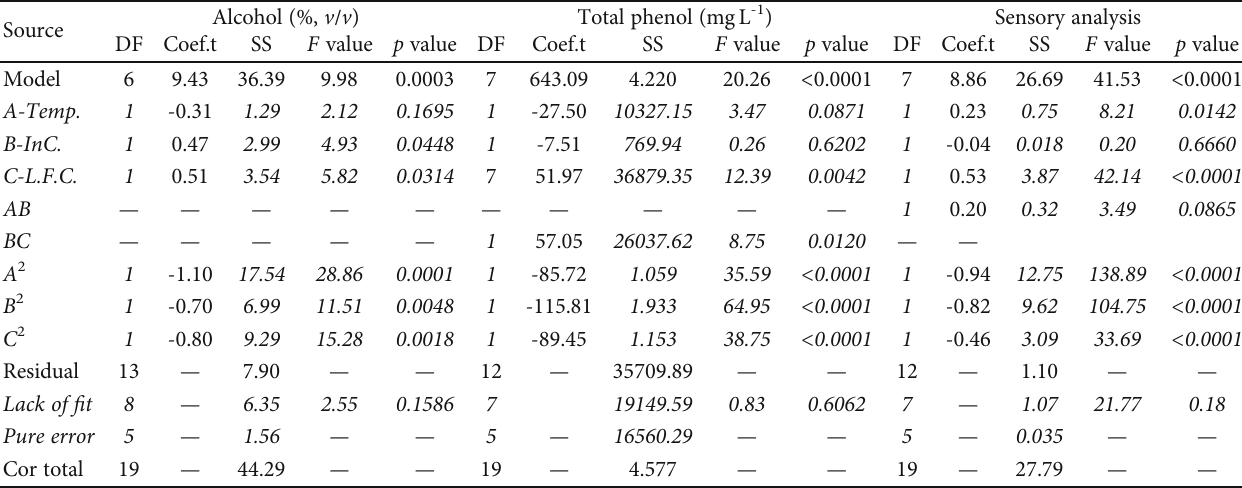
Table 5: ANOVA evaluation of linear, interaction, and quadratic terms for alcohol, total phenol, and sensory response variables and coe ffi cients of model prediction. Source A-Temp. C-L.F.C.